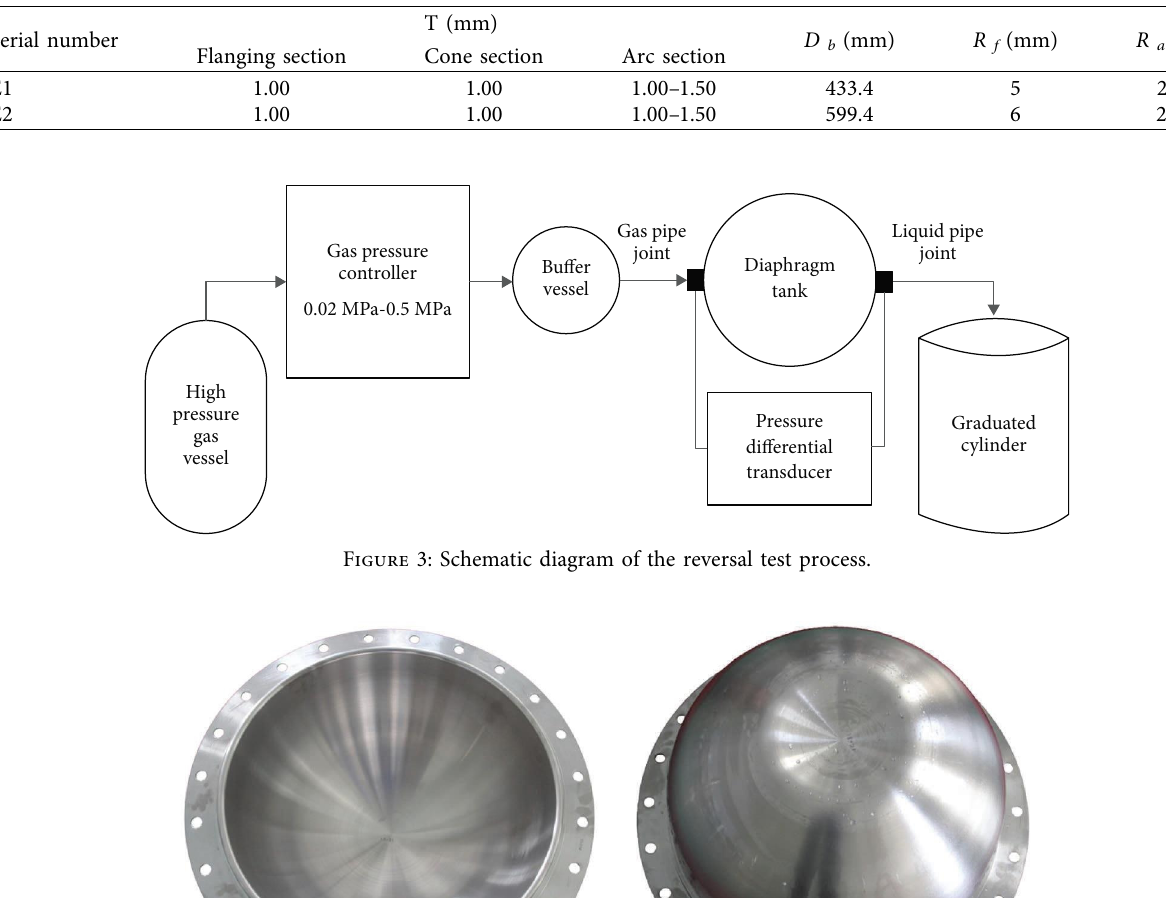
Table 2: Key structural parameters of two diaphragms.